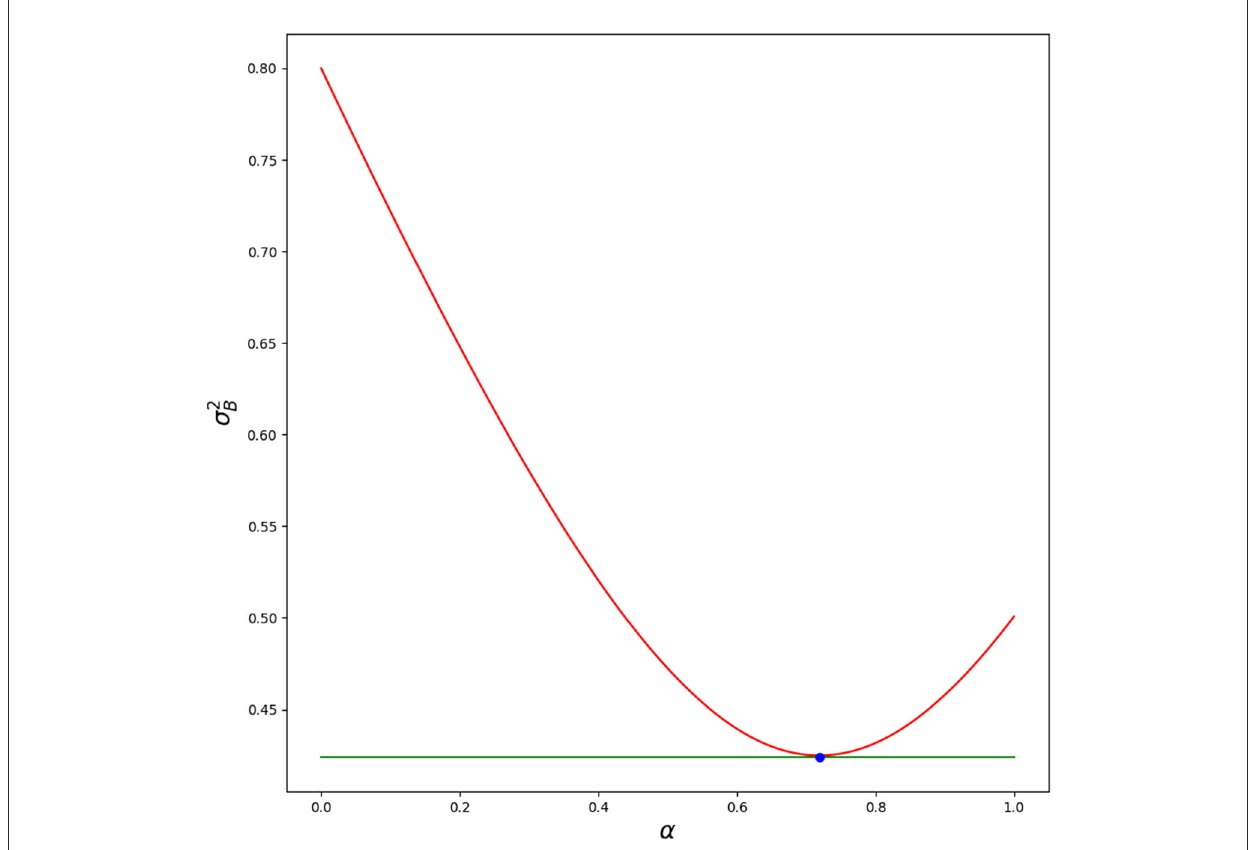
FIGURE1 Red line—variance for different α . Green line—optimal variance σ 2 B . Blue dot—optimal α with its value σ 2 B ( ˆ α ). Python script is in Appendix